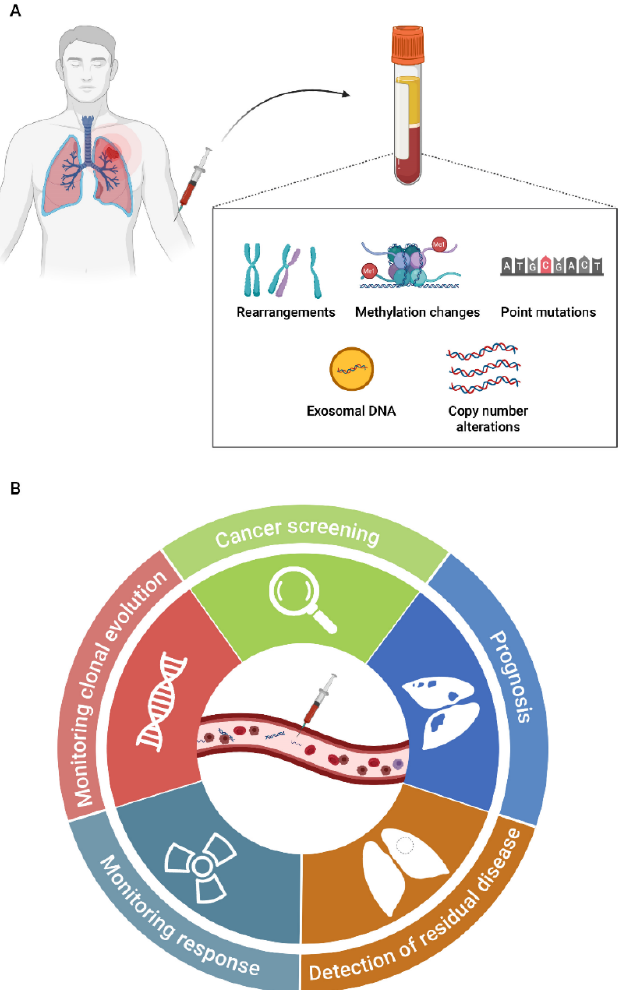
Figure 2. Potential clinical applications of ctDNA in small cell lung cancer (SCLC ) patients. ( A ) Range of alterations in cell-free DNA; ( B ) applications of ctDNA analysis during the course of the disease management.